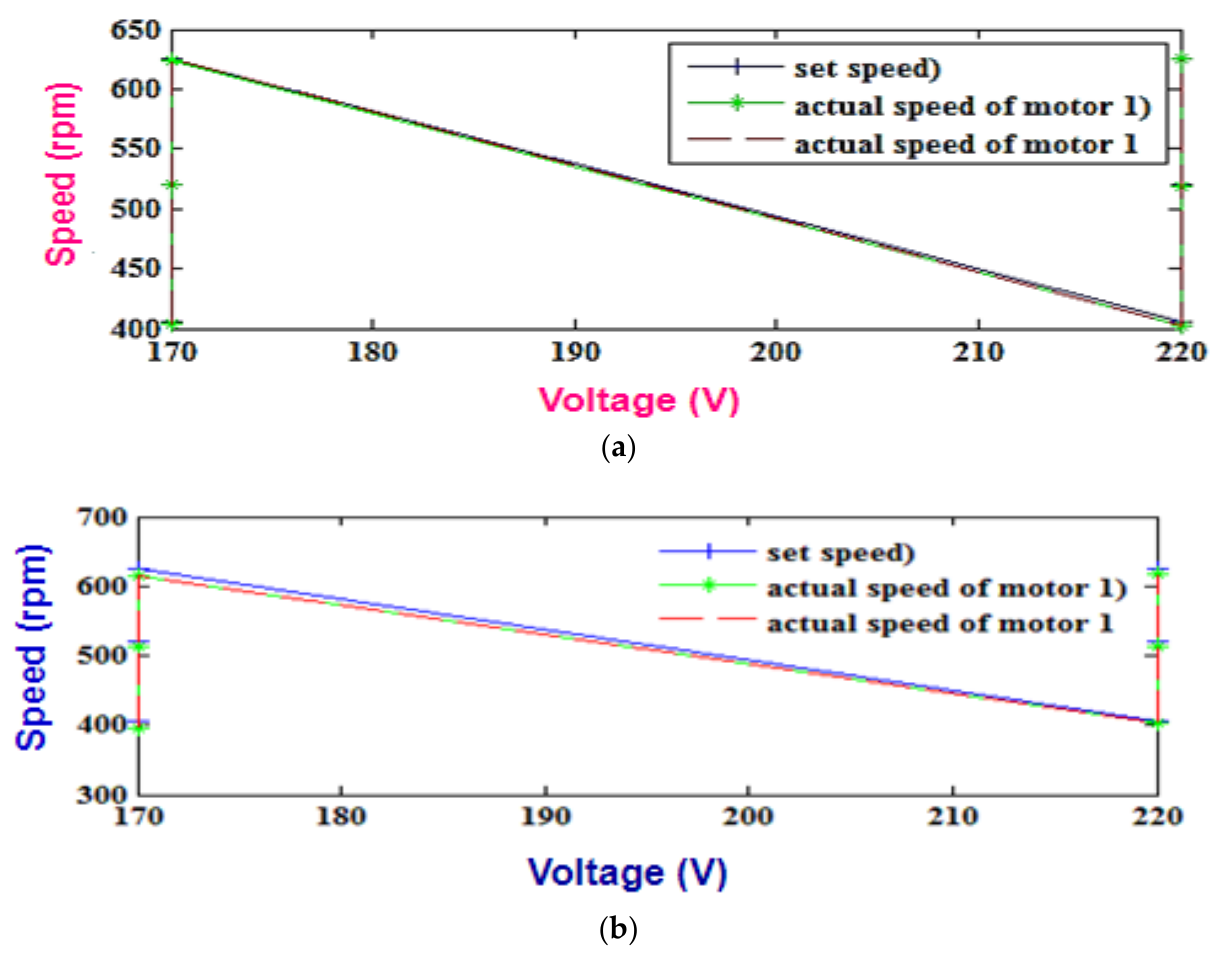
Figure 28. Speed response of sensorless IM drive: ( a ) steady-state condition; ( b ) parameter variation.